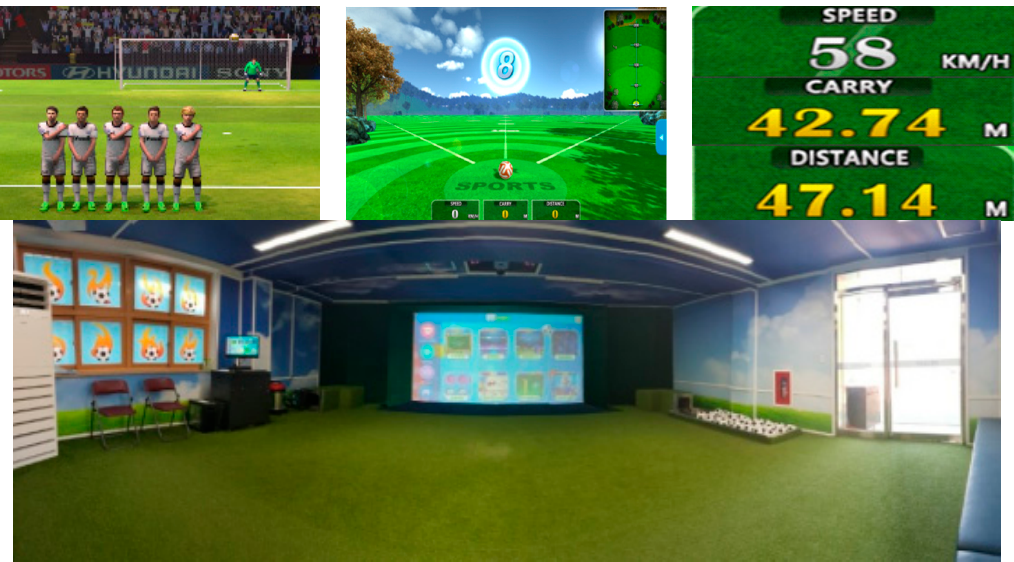
Figure 12. Screen-based sports simulation: Software contents ( top ) and room ( bottom ) to train a user’s sports skills such as soccer kicks and baseball hits.